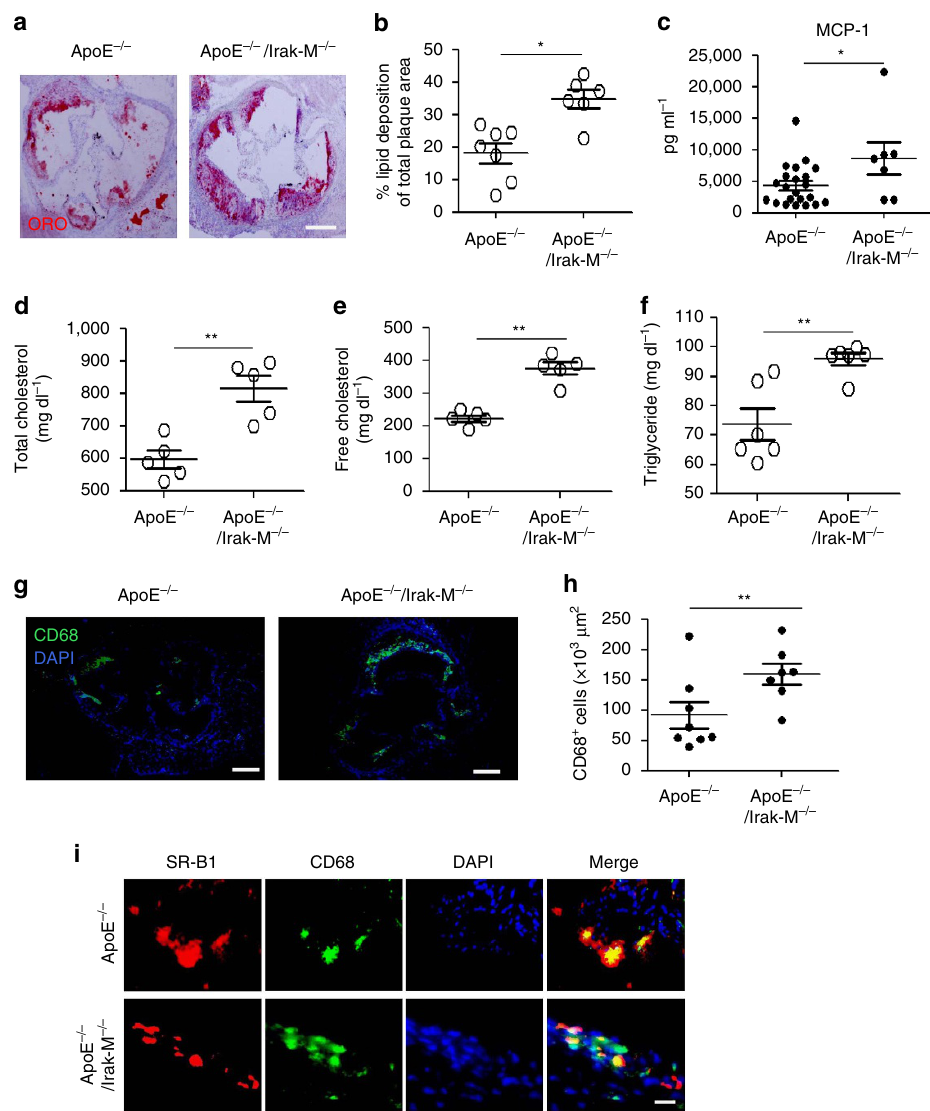
Figure 8 | Lack of IRAK-M results in exacerbated atherosclerosis. ApoE (cid:2) / (cid:2) and ApoE (cid:2) / (cid:2) / Irak-M (cid:2) / (cid:2) mice were fed with HFD for 8 weeks. ( a ) Representative images of atherosclerotic plaques within aortic root areas stained by Oil Red O. Scale, 300 m m. ( b ) Quantification of the lipid deposition area as a percentage of the total atherosclerotic plaque area within the aortic root. Data are shown for aortic plaque areas from ApoE (cid:2) / (cid:2) ( n ¼ 7) and ApoE (cid:2) / (cid:2) / Irak-M (cid:2) / (cid:2) ( n ¼ 6) mice. ( c ) Levels of plasma MCP-1 from ApoE (cid:2) / (cid:2) ( n ¼ 22) and ApoE (cid:2) / (cid:2) / Irak-M (cid:2) / (cid:2) ( n ¼ 7) mice. Levels of total ( d ) and free cholesterol ( e ) in the plasma. Data are shown from ApoE (cid:2) / (cid:2) ( n ¼ 5) and ApoE (cid:2) / (cid:2) / Irak-M (cid:2) / (cid:2) ( n ¼ 5) mice. ( f ) Triglyceride levels in the plasma from ApoE (cid:2) / (cid:2) ( n ¼ 6) and ApoE (cid:2) / (cid:2) / Irak-M (cid:2) / (cid:2) ( n ¼ 6) mice. ( g ) Representative images of CD68 þ macrophages in the atherosclerotic plaques of aortic root areas. Scale bar, 300 m m. ( h ) Quantification of CD68 þ macrophages number per m m 2 in the lesion area of aortic root. Data are shown for aortic plaque areas from ApoE (cid:2) / (cid:2) ( n ¼ 8) and ApoE (cid:2) / (cid:2) / Irak-M (cid:2) / (cid:2) ( n ¼ 7) mice. ( i ) Representative images of atherosclerotic plaques within aortic root areas co-stained with 4,6-diamidino-2-phenylindole (DAPI), as well as antibodies against SR-B1, CD68. Scale bar, 100 m m. All data are representative of two similar experiments. Error bars show means ± s.e.m. * P o 0.05 and ** P o 0.01; Student’s t